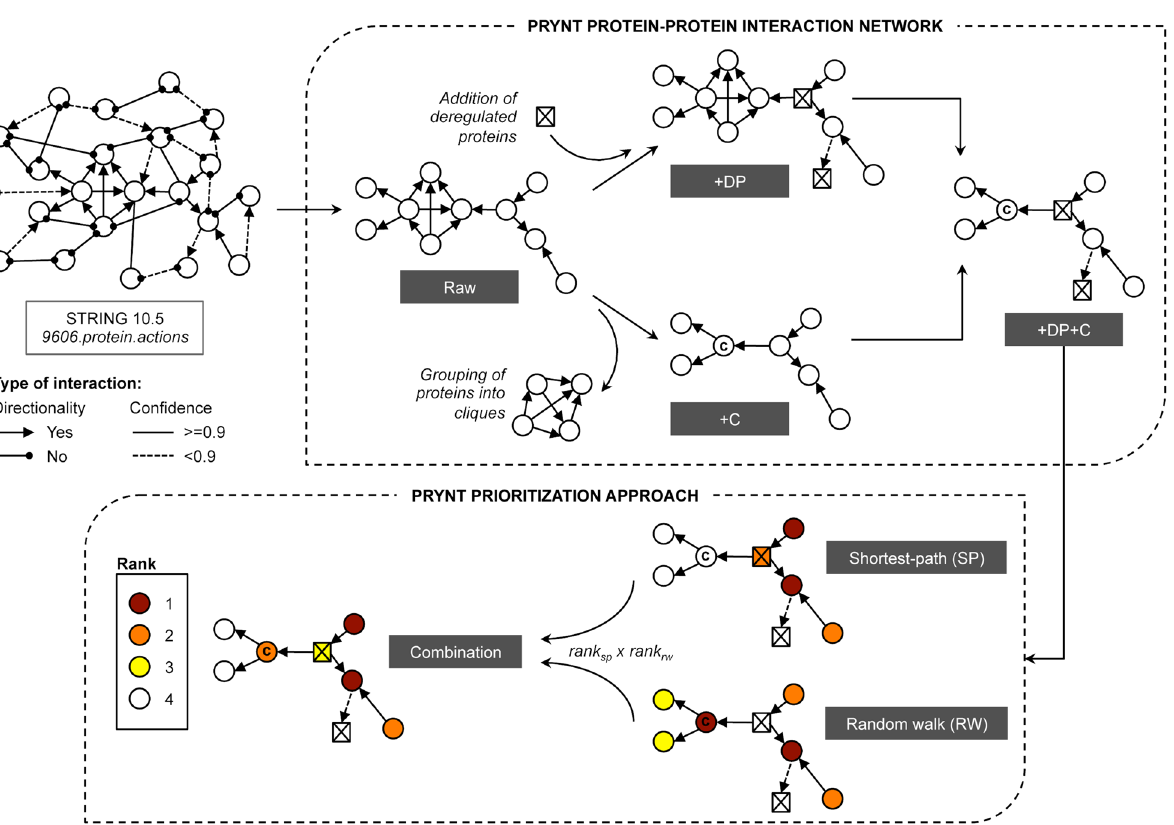
Figure 2. Description of PRYNT algorithm. PRYNT PPI network was based on STRING 10.5 protein.actions restricted to Homo sapiens ( 9606.protein.actions ), and only directional interaction with confidence > = 0.9 were selected. The raw PPI network (Raw) was further contextualized by adding the deregulated proteins (+DP) regardless of their confidence level and by grouping the proteins within cliques (+C). PRYNT prioritization approach was based on the combination of shortest-path (SP) and random walk (RW) algorithms and was achieved by multiplying the rank of the protein with the shortest-path ranking strategy (ranksp), and the rank of the protein with the random walk strategy (rankrw). PPI: protein–protein interaction network; DP: deregulated proteins; C: